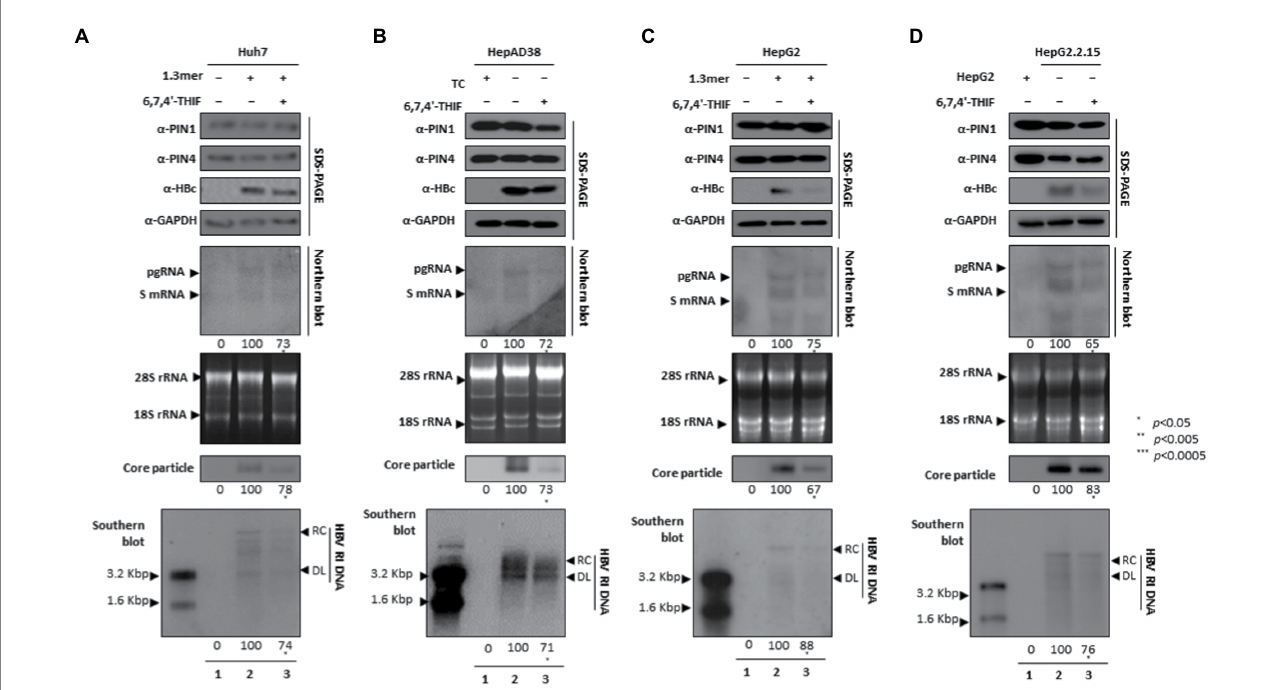
FIGURE 6 PIN1 and PIN4 inhibition via 6,7,4 ′ -THIF reduced HBV replication in Huh7, HepAD38, HepG2, and HepG2.2.15. (A–D) 6,7,4 ′ -THIF abrogated HBV replication. (A) The Huh7 cells were mock-transfected (lane 1), transfected with 4 μ g of 1.3 mer HBV WT and treated with DMSO (lane 2), or transfected by 1.3 mer HBV WT (4 μ g) and treated with 30 μ M of 6,7,4 ′ -THIF for 72 h (lane 3). (B) HepAD38 was treated with mock (none, lane 1) or DMSO (lane 2), or treated with 30 μ M 6,7,4 ′ -THIF (lane 3) for 72 h. (C) HepG2 cells were transfected with mock (lane 1), 1.3 mer HBV WT (4 μ g) transfected and treated with DMSO (lane 2), or 4 μ g 1.3 mer HBV WT transfected and treated with 6,7,4 ′ -THIF (30 μ M) for 72 h (lane 3). (D) HepG2.2.15 cells were treated with DMSO (lane 2) or 6,7,4 ′ -THIF (30 μ M) treated for 72 h (lane 3). Lane 1 indicates mock-transfected HepG2 cells (negative control). The lysates were subjected to SDS-PAGE and immunoblotting, NAGE, Northern, and Southern blotting. The presented data are representative of three independent experiments. The statistical analysis was determined using Student’s t -test. * p < 0.05, ** p < 0.005, *** p < 0.0005 relative to the